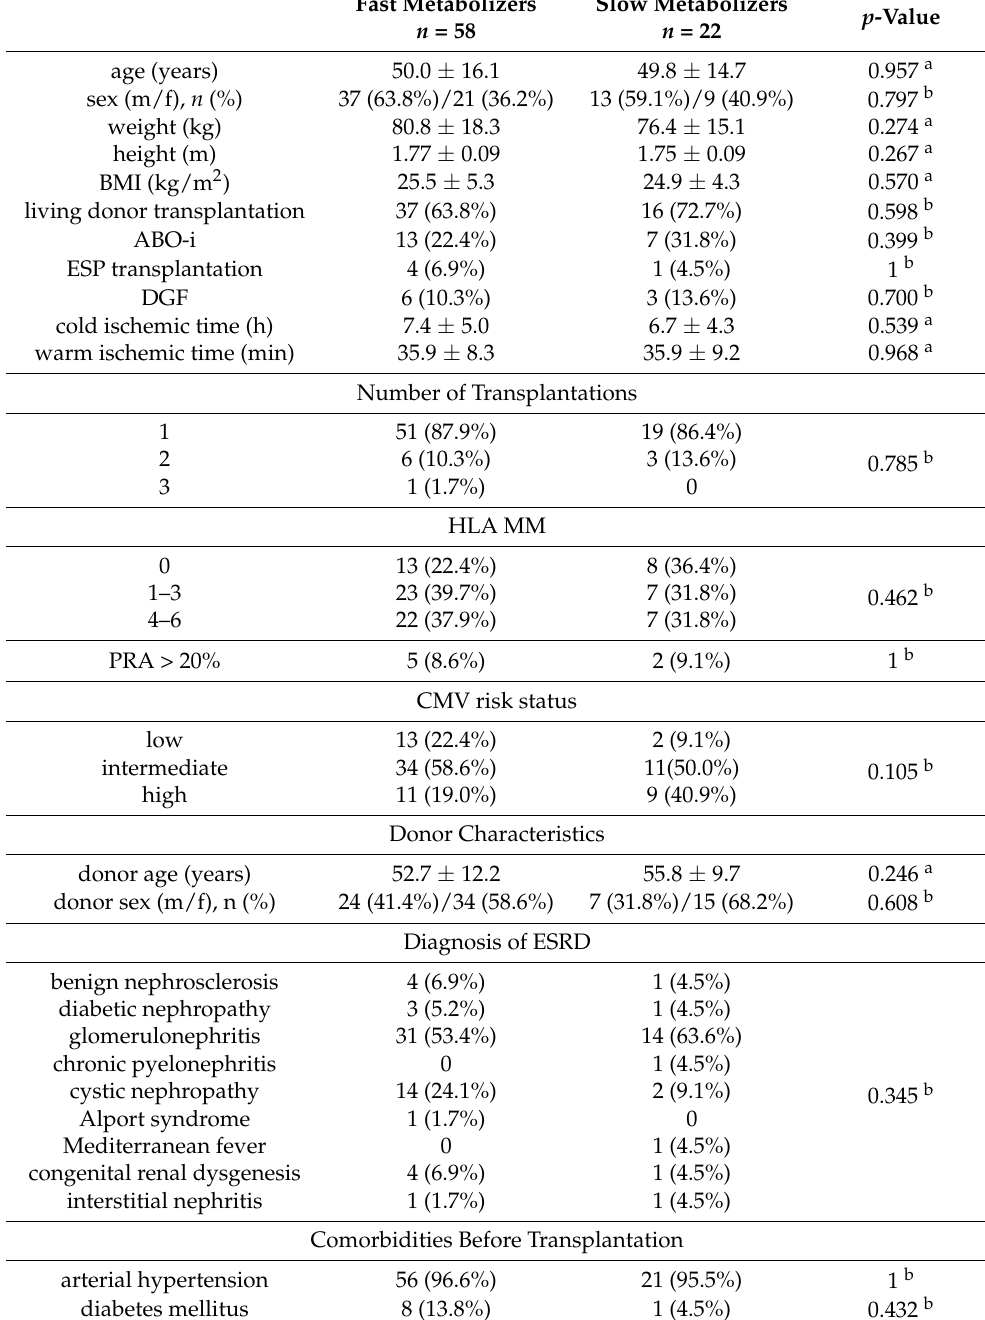
Table 1. Patients’